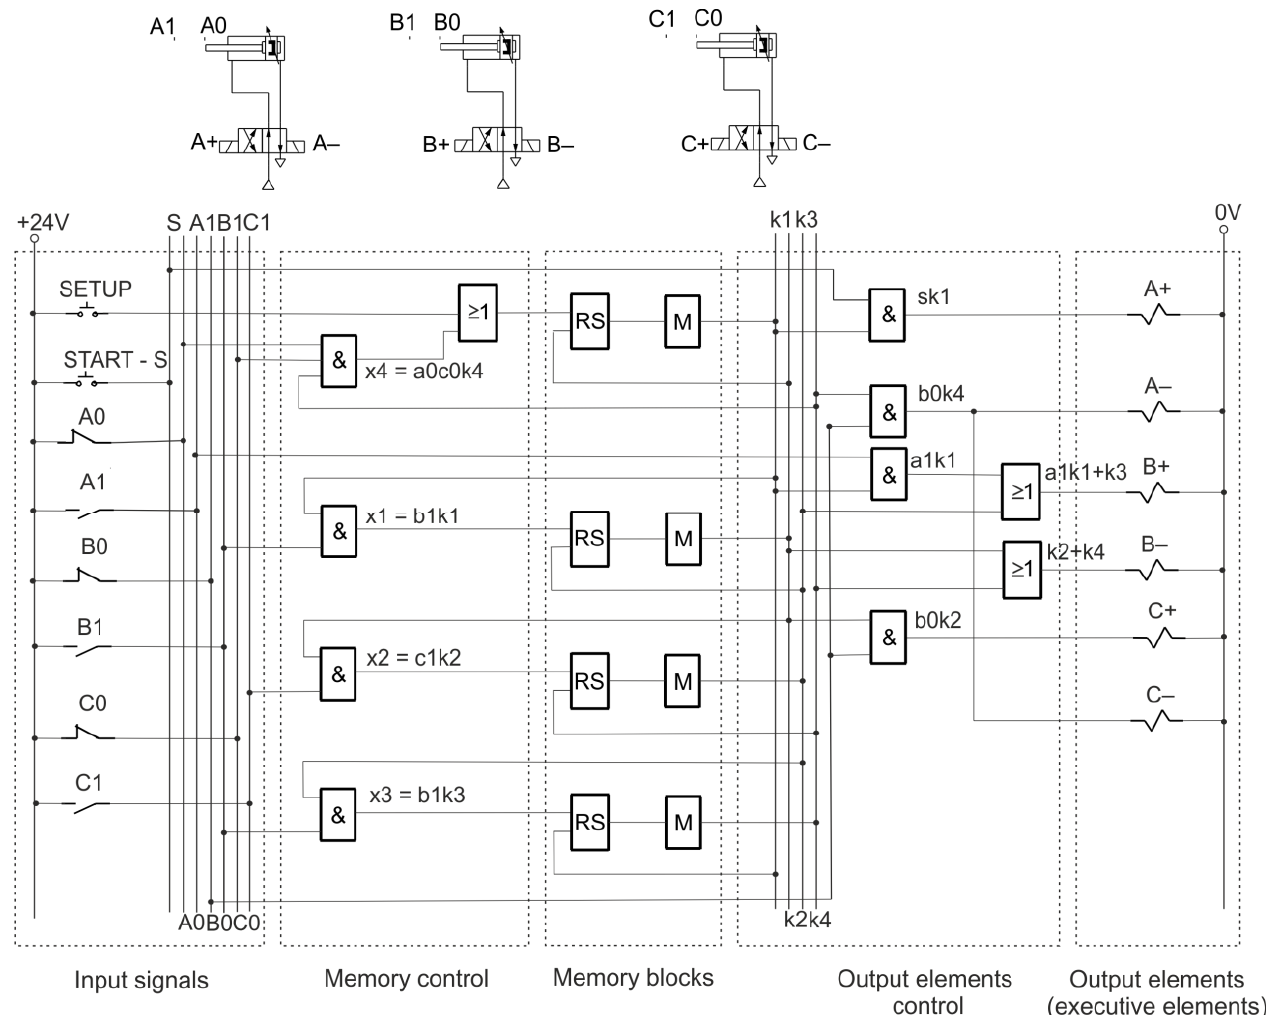
Figure 5. Diagram of the electro-pneumatic system with the use of logic circuits.